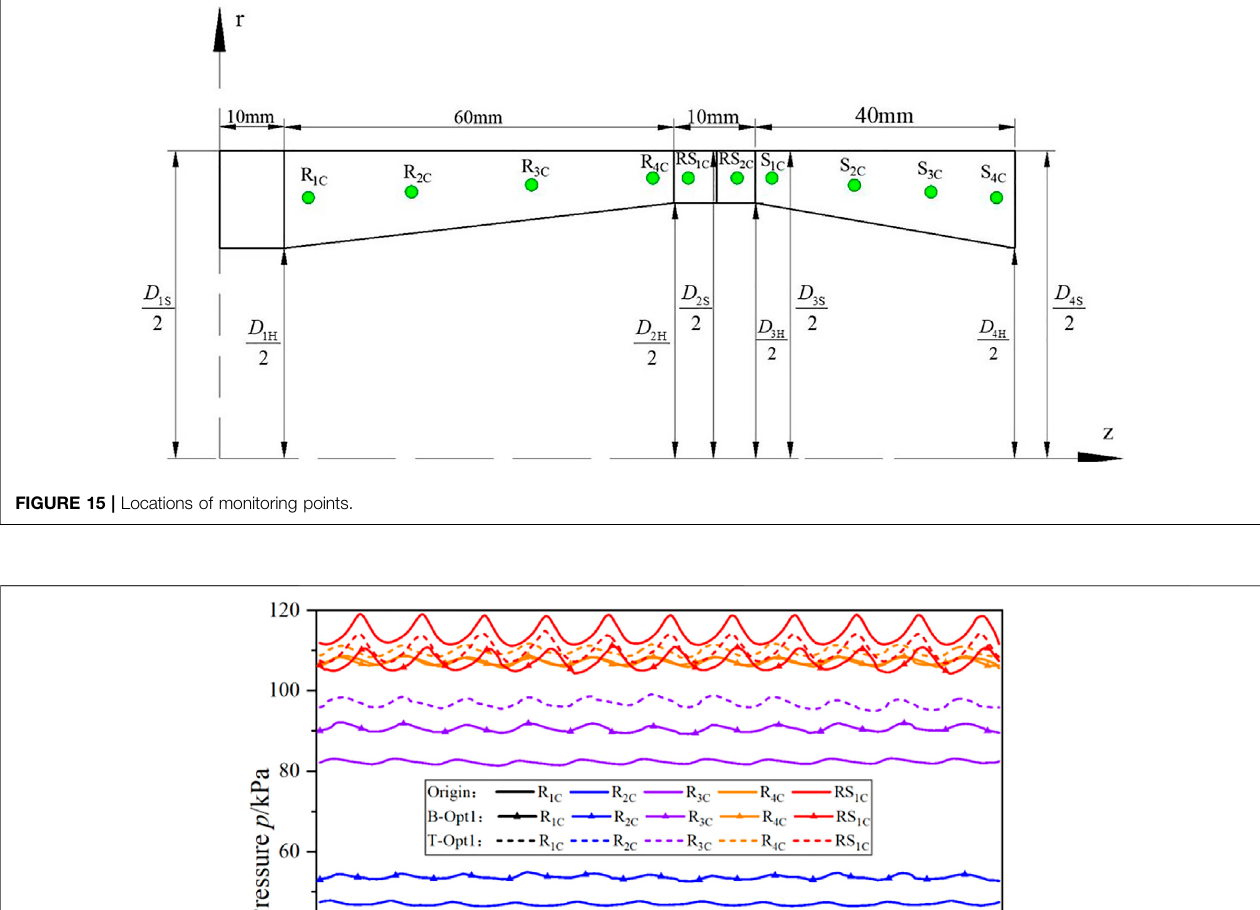
Frontiers in Energy Research |